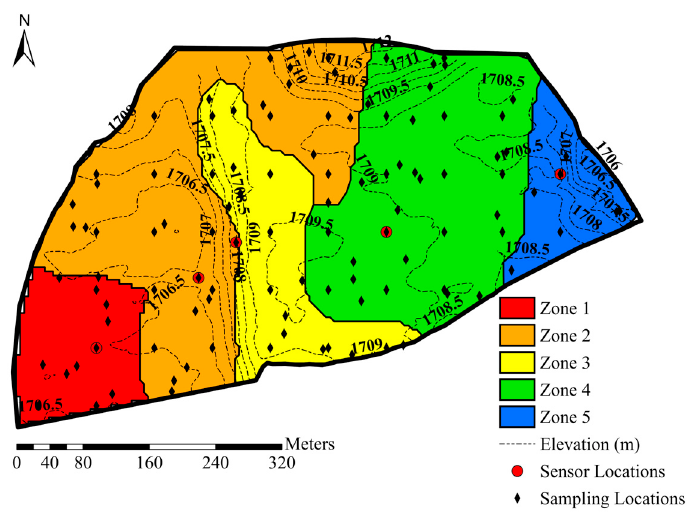
Figure 1. Image of field research site near Grace, ID, USA, with elevation contour lines (m), 2019 VRI management zones, soil sample points, and soil volumetric water content (VWC) sensor locations.